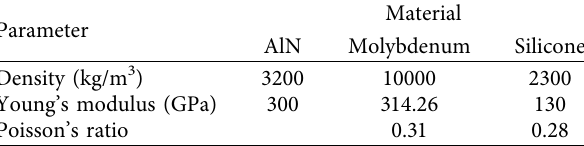
Table 3: Te physical material parameters of the FBAR sensor. Parameter